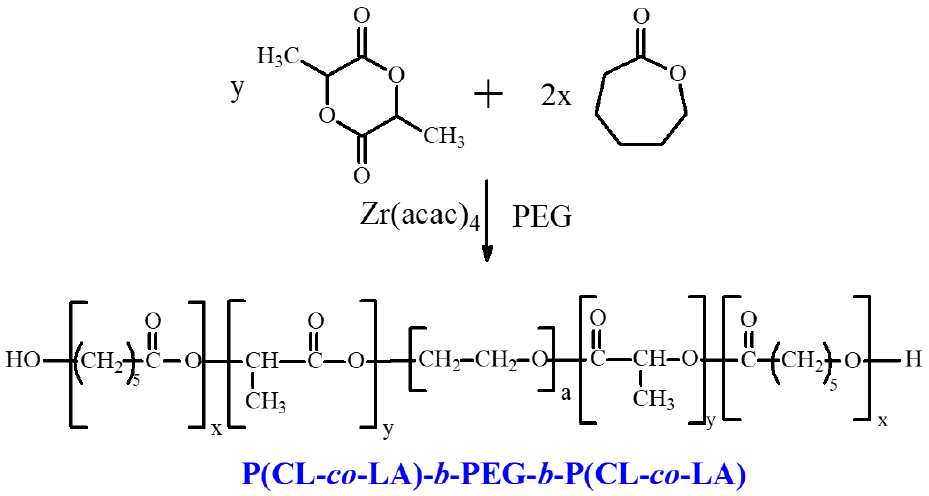
Figure 1. The PCLA synthesis via the ROP